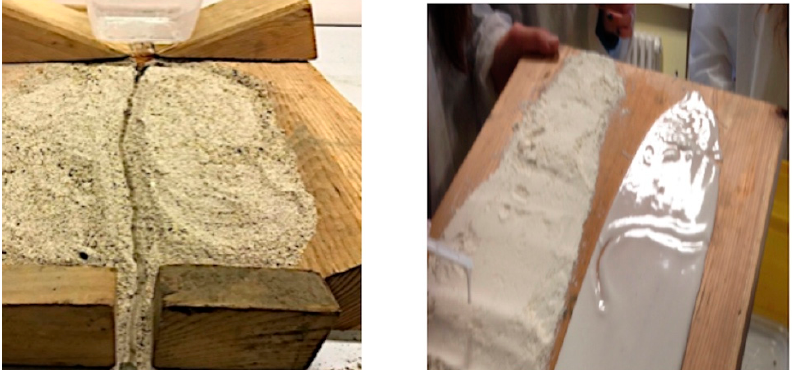
Figure 4. Models of different phenomena (erosion or avalanche).